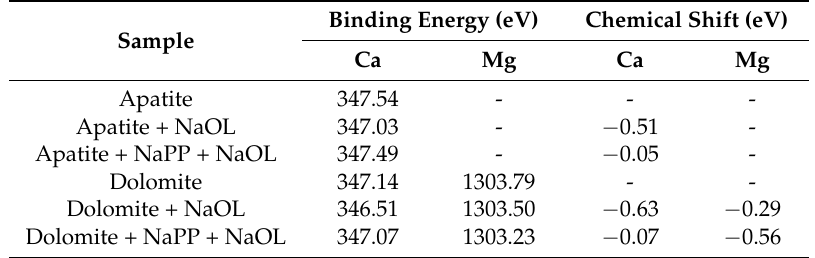
Table 2. Binding energy of elements on the minerals surface under different reagent conditions.